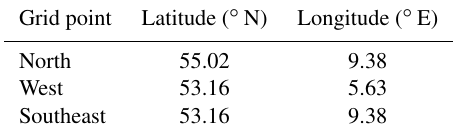
Table 1. Coordinates of the three grid points used for storm activity calculation in the model.